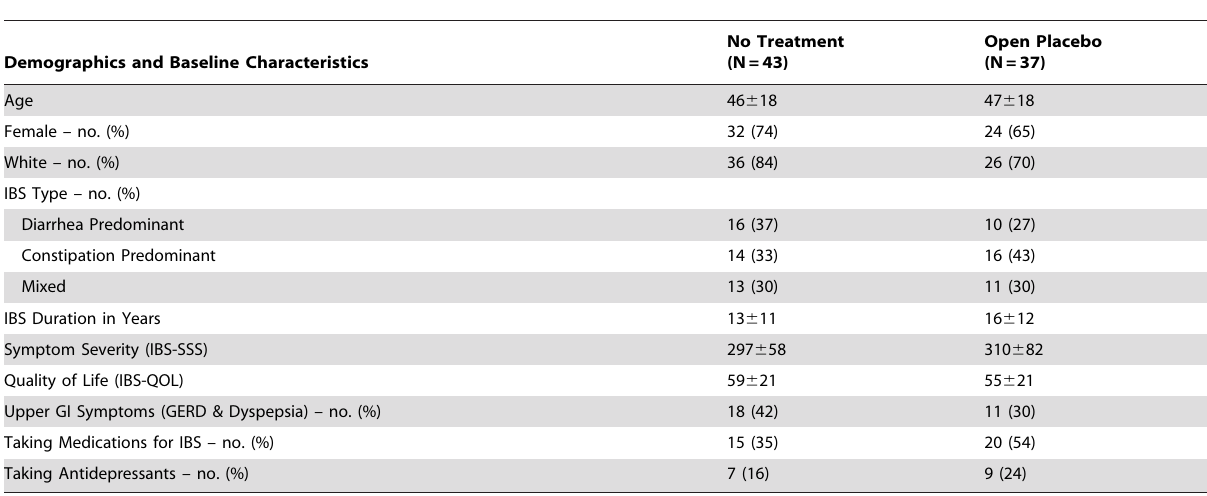
Table 1. Demographics and Baseline